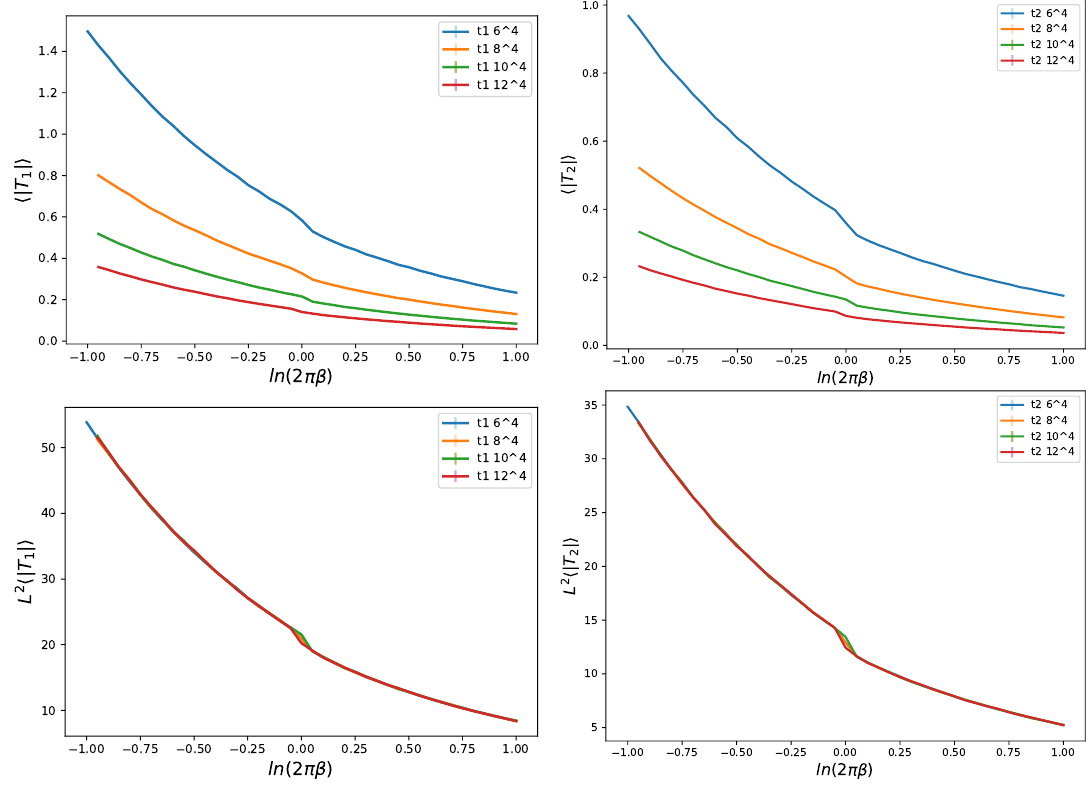
Figure 9 . Results for the C -breaking order parameters T 1 and T 2 . In the top row of plots we show h| T 1 |i (lhs.) and h| T 2 |i (rhs.) for different volumes L 4 with L = 8 , 10 , 12 , 14 . The results are plotted as a function of ln(2 πβ ) and we use a matter field coupling of J = 0 . 65 . In the bottom row of plots we show the rescaled expectation values L 2 h| T 1 |i (lhs.) and L 2 h| T 2 |i (rhs.), illustrating that the √ expectation values vanish as 1 /L 2 = 1 / V . All error bars are smaller than the line width.